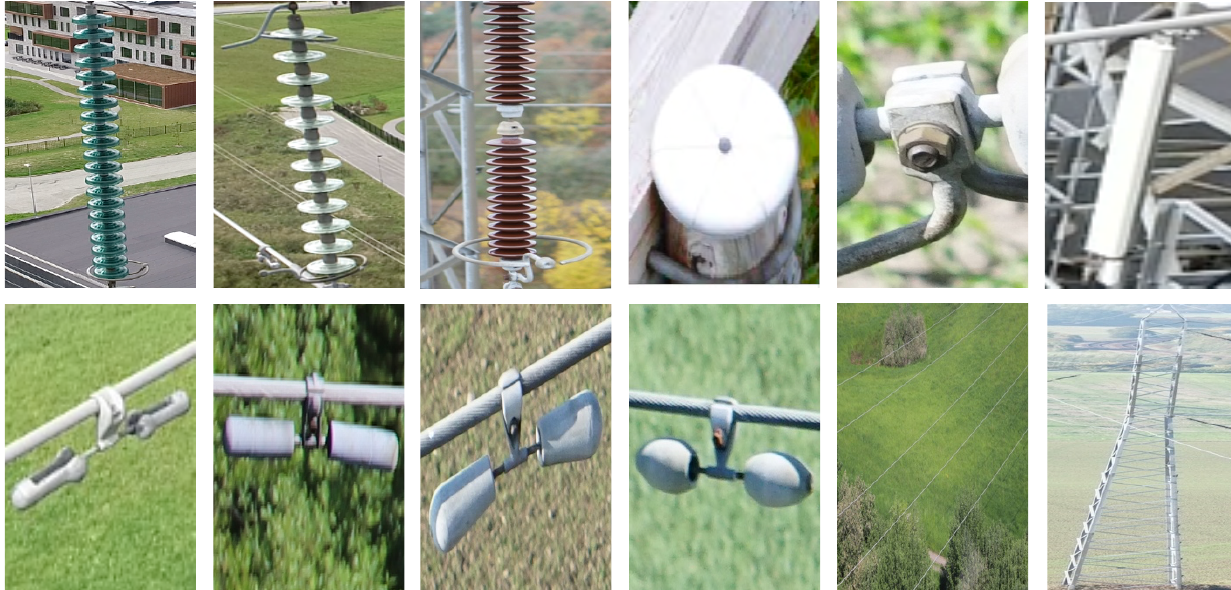
Figure 1. Sample images of normal component classes used to train the DL model (from top left to bottom right): Insulator Type 1, Insulator Type 2, Insulator Type 3, normal top pad [2], normal nut-bolt, antenna, Vibration Dampener Type 1, Vibration Dampener Type 2, Vibration Dampener Type 3, Vibration Dampener Type 4, normal electric transmission wires, and pylon, respectively.